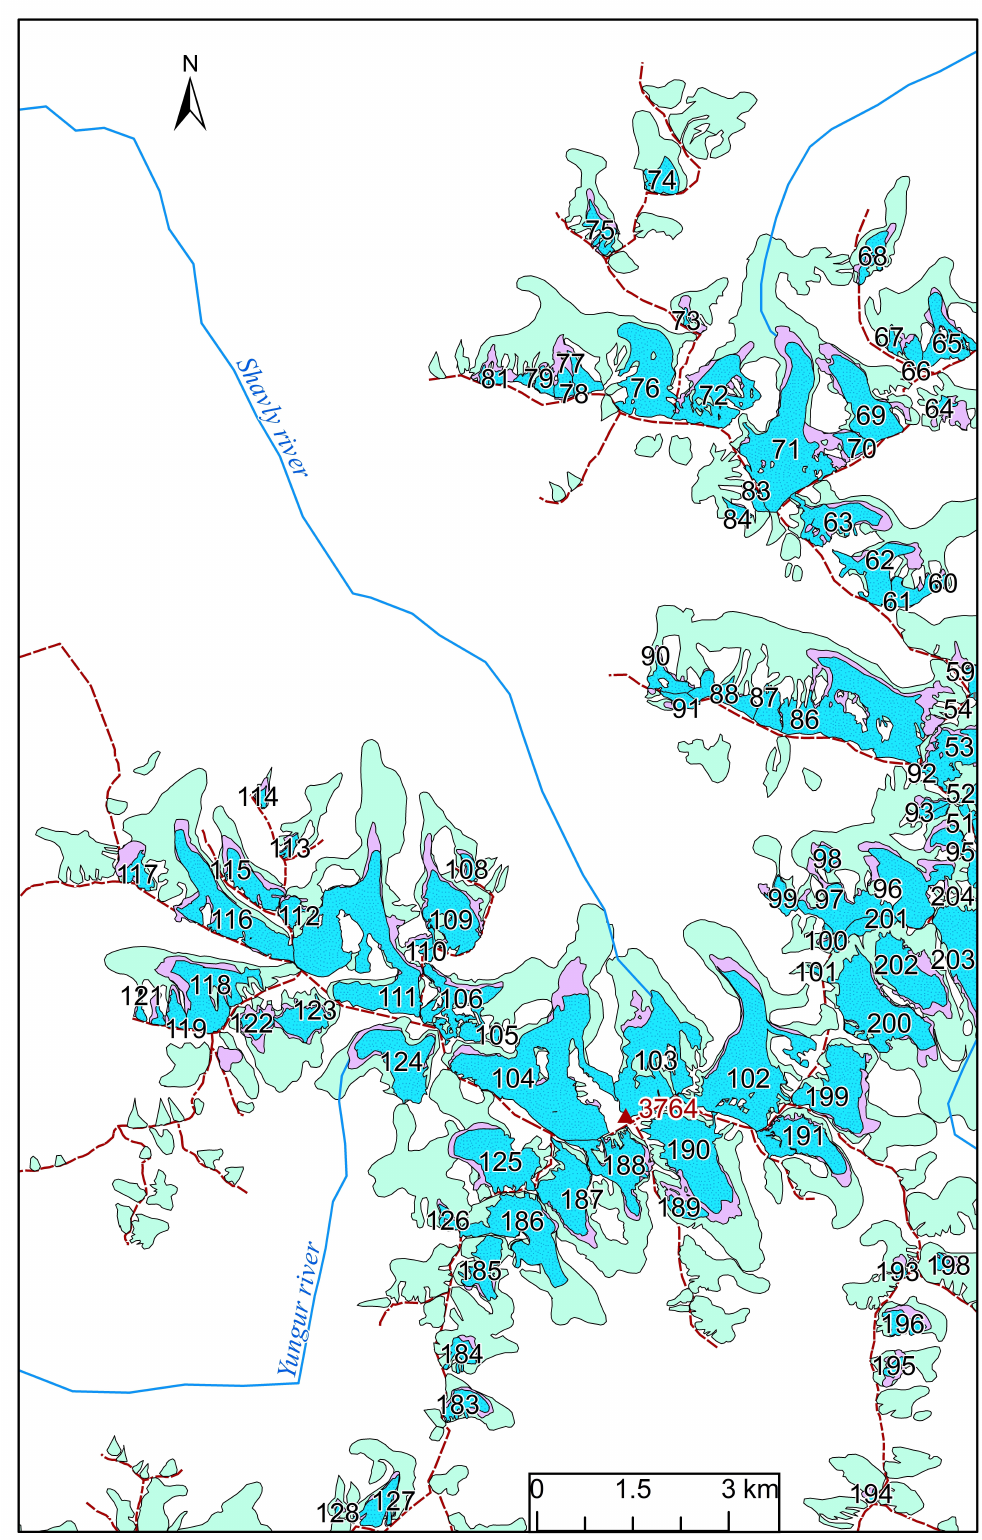
Figure 8. Reduction of the glaciers of the central part of the North-Chuya range, the basins of Shavly and Yungur (upper part) rivers, after the LIA